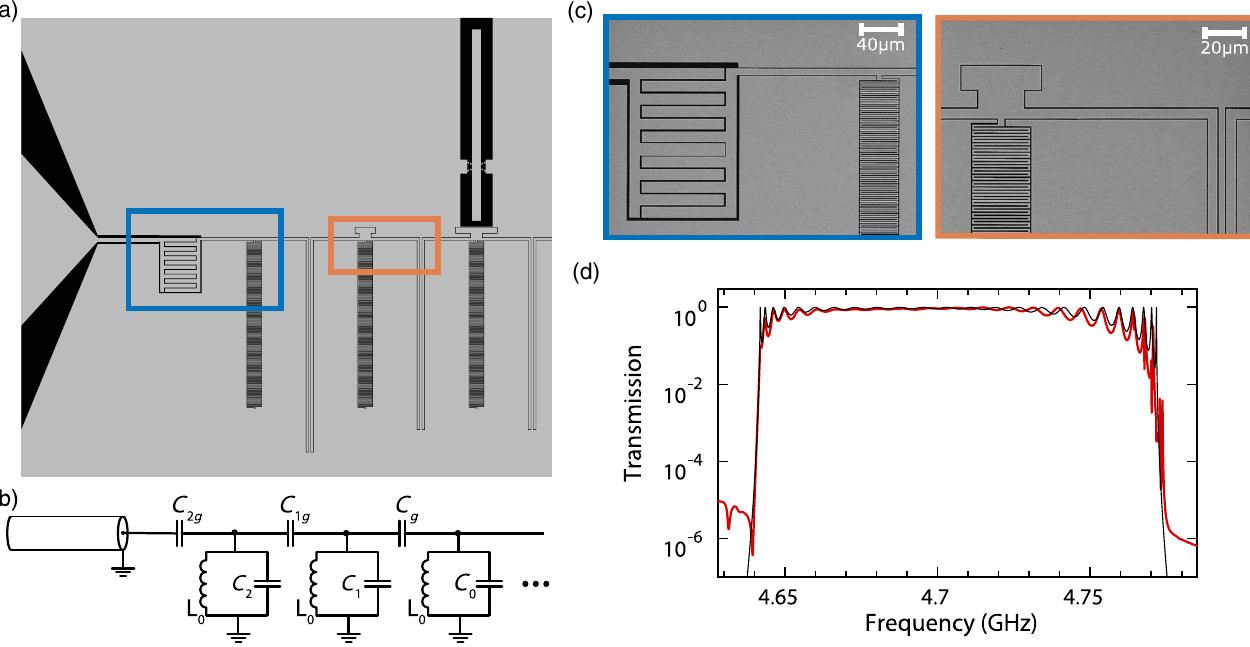
FIG. 7. (a) CAD diagram showing the end of the finite resonator array, including the boundary-matching circuit (which in this case includes the first two resonators) and the first unit cell. (b) Corresponding circuit model of the end of the finite resonator array. (c) Enlarged SEM images of the first (left) and second (right) boundary-matching resonators. (d) Transmission spectrum of the full resonator array consisting of 22 unit cells and two boundary-matching resonators on either end of the array (for a total of 26 resonators). Measured data are plotted as a red curve, and the circuit model fit is plotted as a black curve. Fit model parameters are given in the